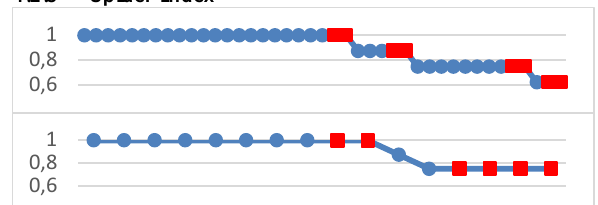
Figure 4: Spider Index Scores for a simple (top) and a complex (bottom) region